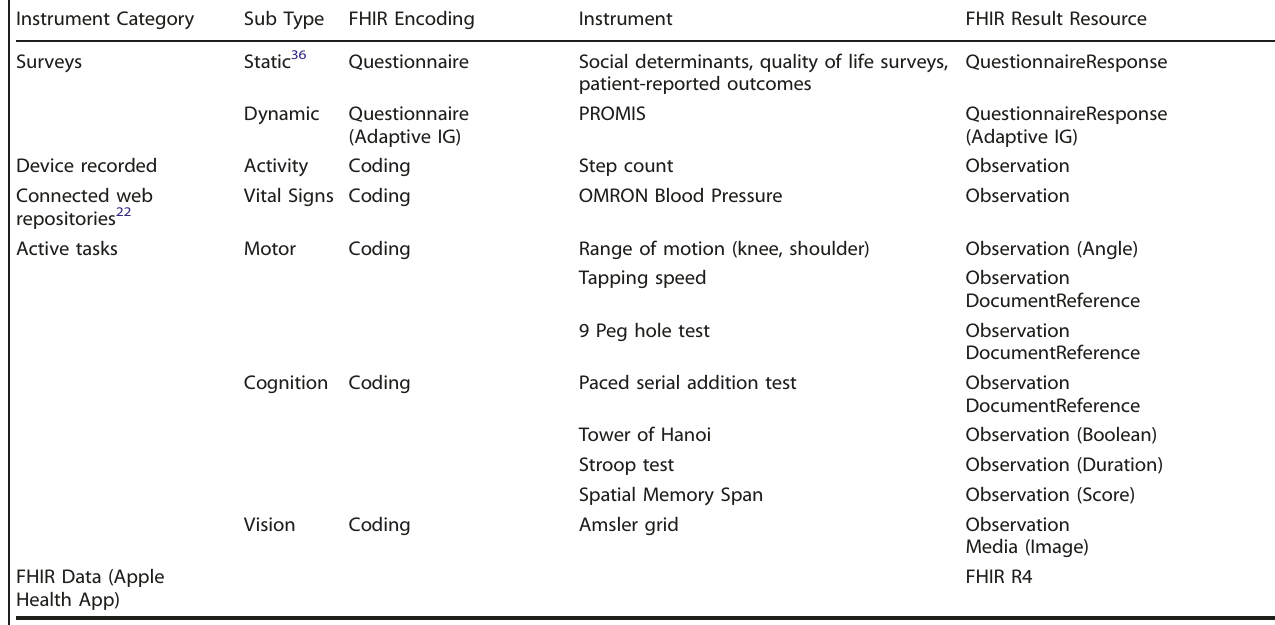
Table 1. FHIR Conformance of PGHD instrument types.